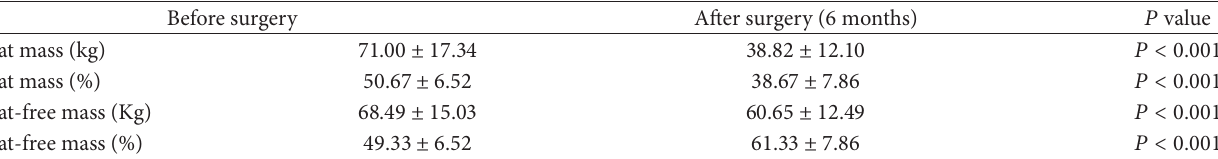
Table 1: Fat mass and fat-free mass before and after bariatric surgery.